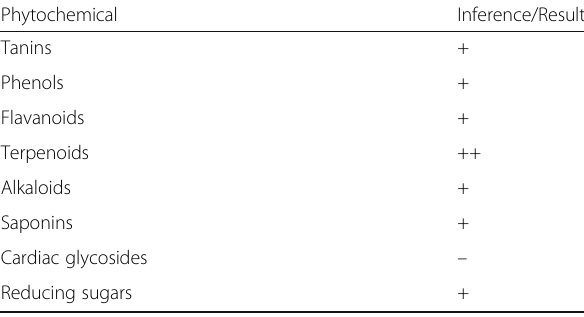
Table 1 In vitro phytochemical analysis of the AR rhizome